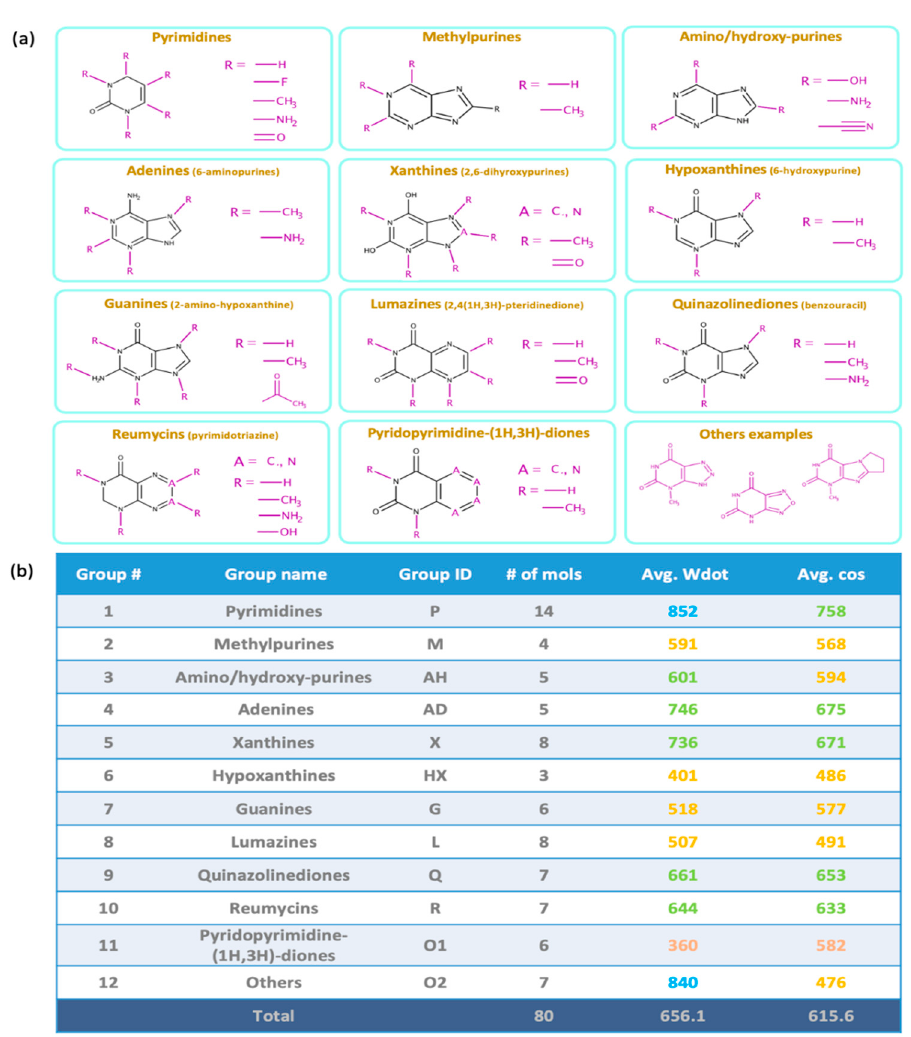
Figure 2. Histogram of MS similarity of QCEIMS predicted versus experimental mass spectra for 80 purines and pyrimidines, comparing weighted dot product and cosine similarity scores.